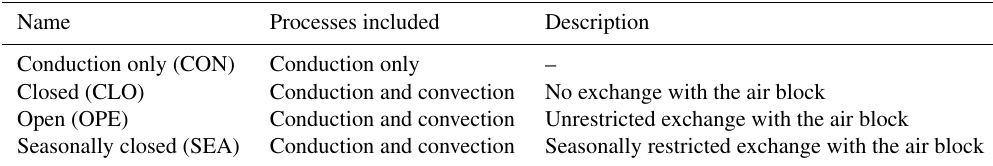
Table 2. List and description of model experiments conducted. Name Processes included Description Conduction only (CON) Conduction only Conduction and convection No exchange with the air block Conduction and convection Unrestricted exchange with the air block Seasonally closed (SEA) Conduction and convection Seasonally restricted exchange with the air